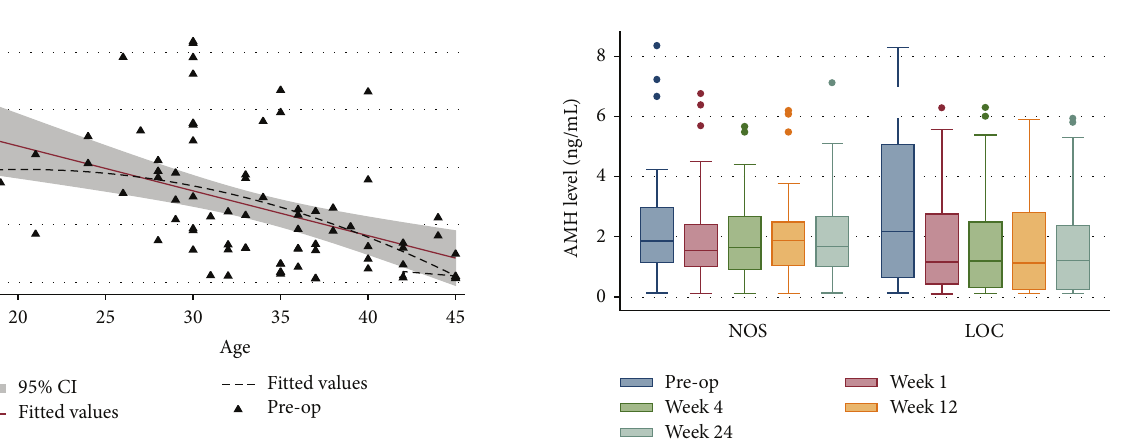
post-op over periods of first week, 1, 3 and 6 months in the LOC and NOS groups. (AMH: antimullerian hormone, LOC: laparoscopic ovarian cystectomy, and NOS: nonovarian laparoscopic pelvic